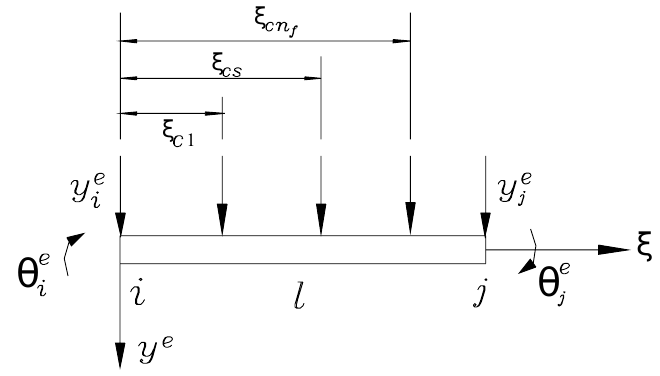
Fig. 2. Model of a Timoshenko beam element with a few moving concentrated forces on